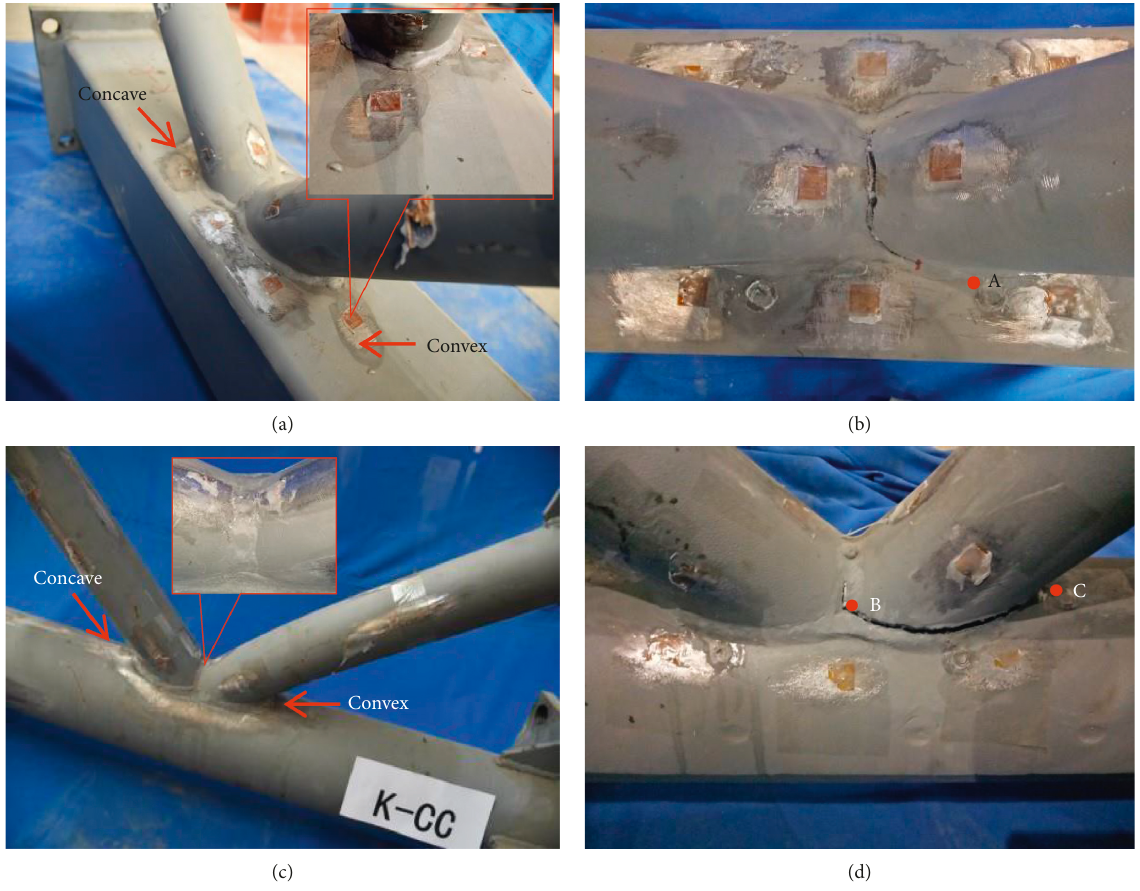
Figure 5: The failure modes of the specimens. (a) K-RC, (b) K-RC1, (c) K-CC, and (d)